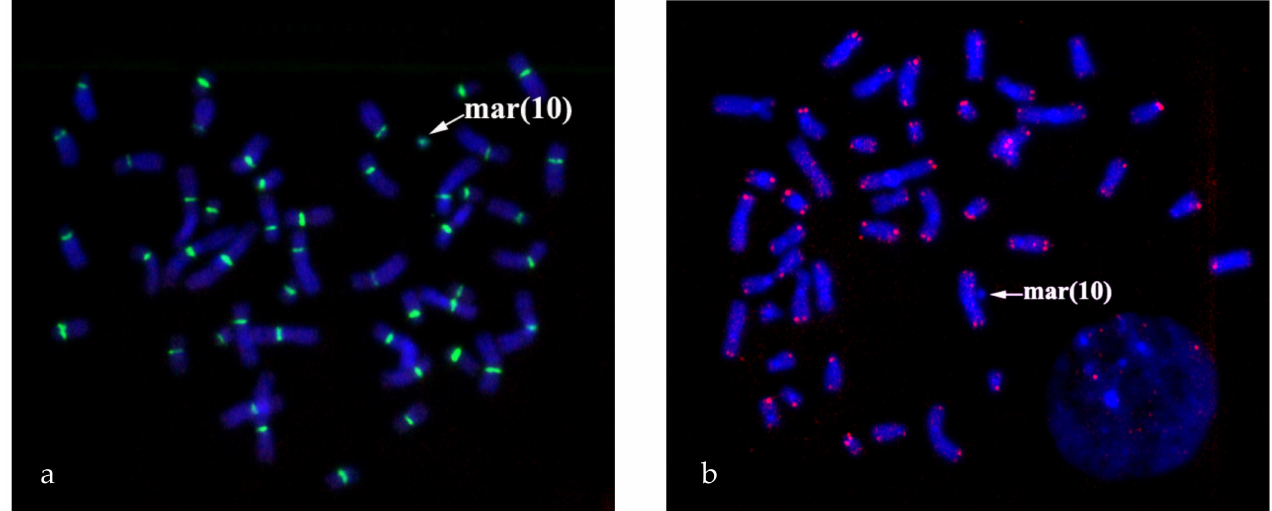
Figure 5. FISH analysis of the sSMC with DNA probes specific to ( a ) centromeric repeats (green signals); and ( b ) telomeric repeats (red signals). Inverted DAPI.